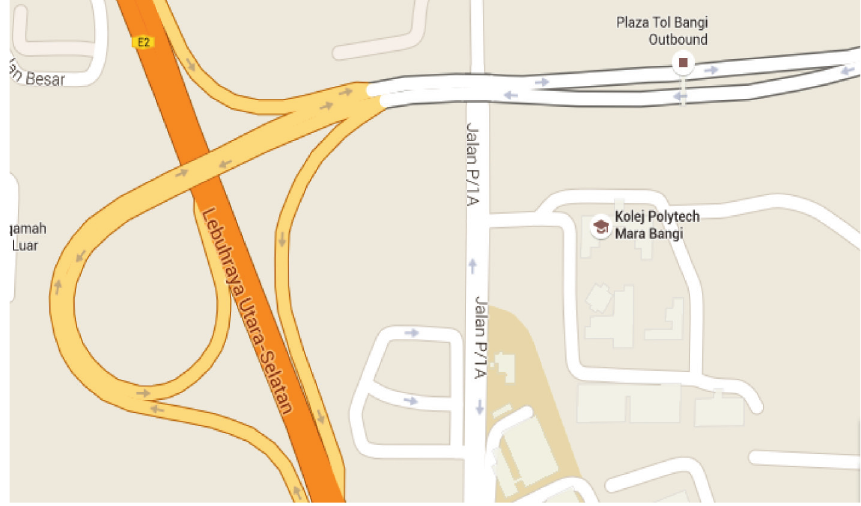
Figure 6: OLSR with IHS in VANET.